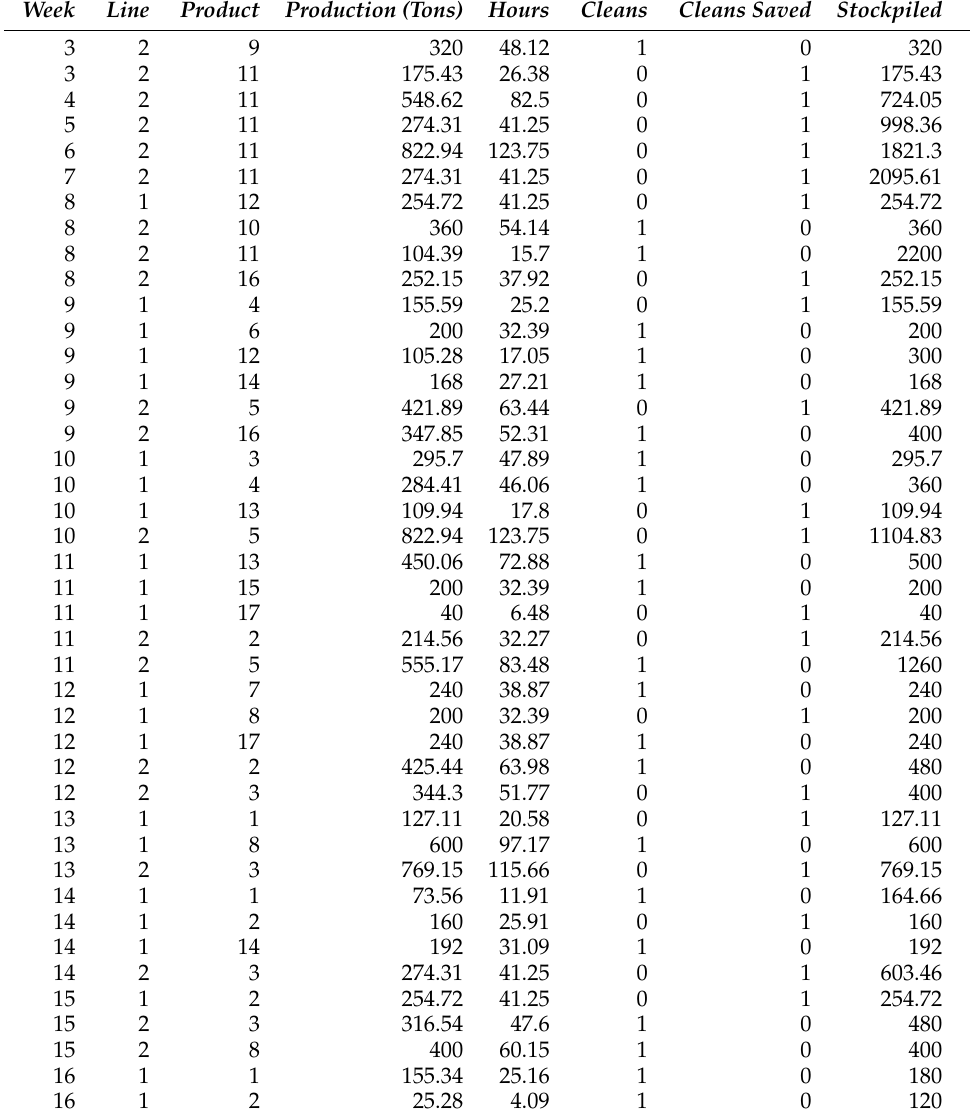
Table 3. Production schedule (in tons) by week for the considered case